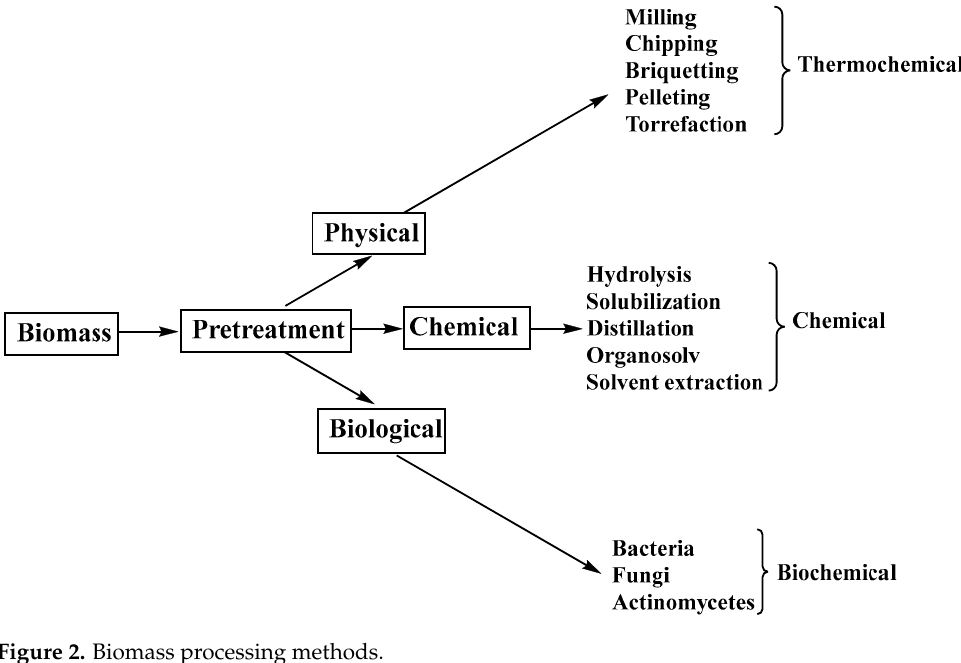
Figure 2. Biomass processing methods.